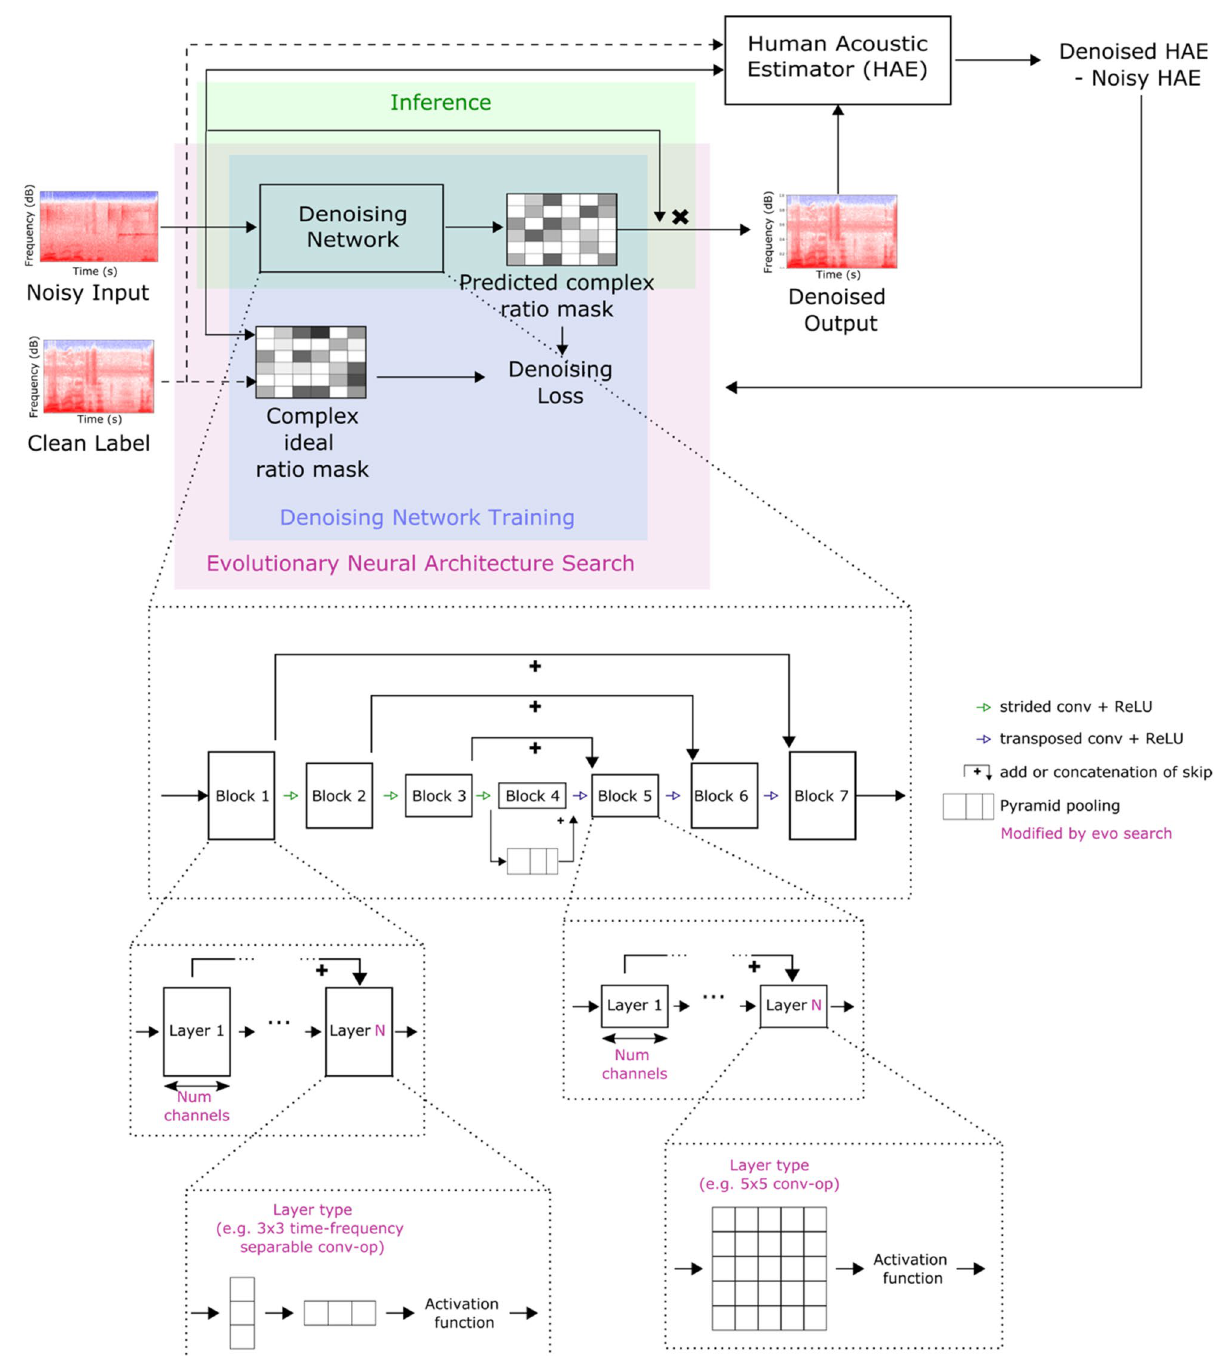
Figure 1. Training pipeline of the denoising system using a mean opinion score (MOS)-estimator-guided neural architecture search. The denoising network is trained to predict denoised outputs from mixed speech and noise input STFTs. To optimize the remaining error for human acoustic perception, the denoising network architecture and hyperparameters are selected by an evolutionary neural architecture search 27–30 . This search is guided by an MOS estimator, which is a deep neural network trained on a dataset generated from around 100,000 human rated audio